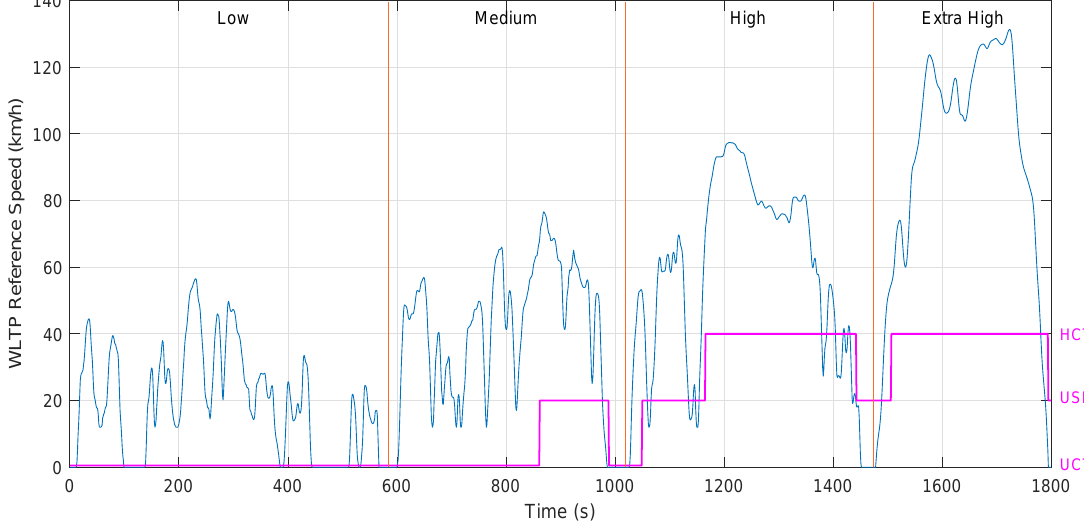
Figure 11. Traffic-condition-type prediction results by the trained